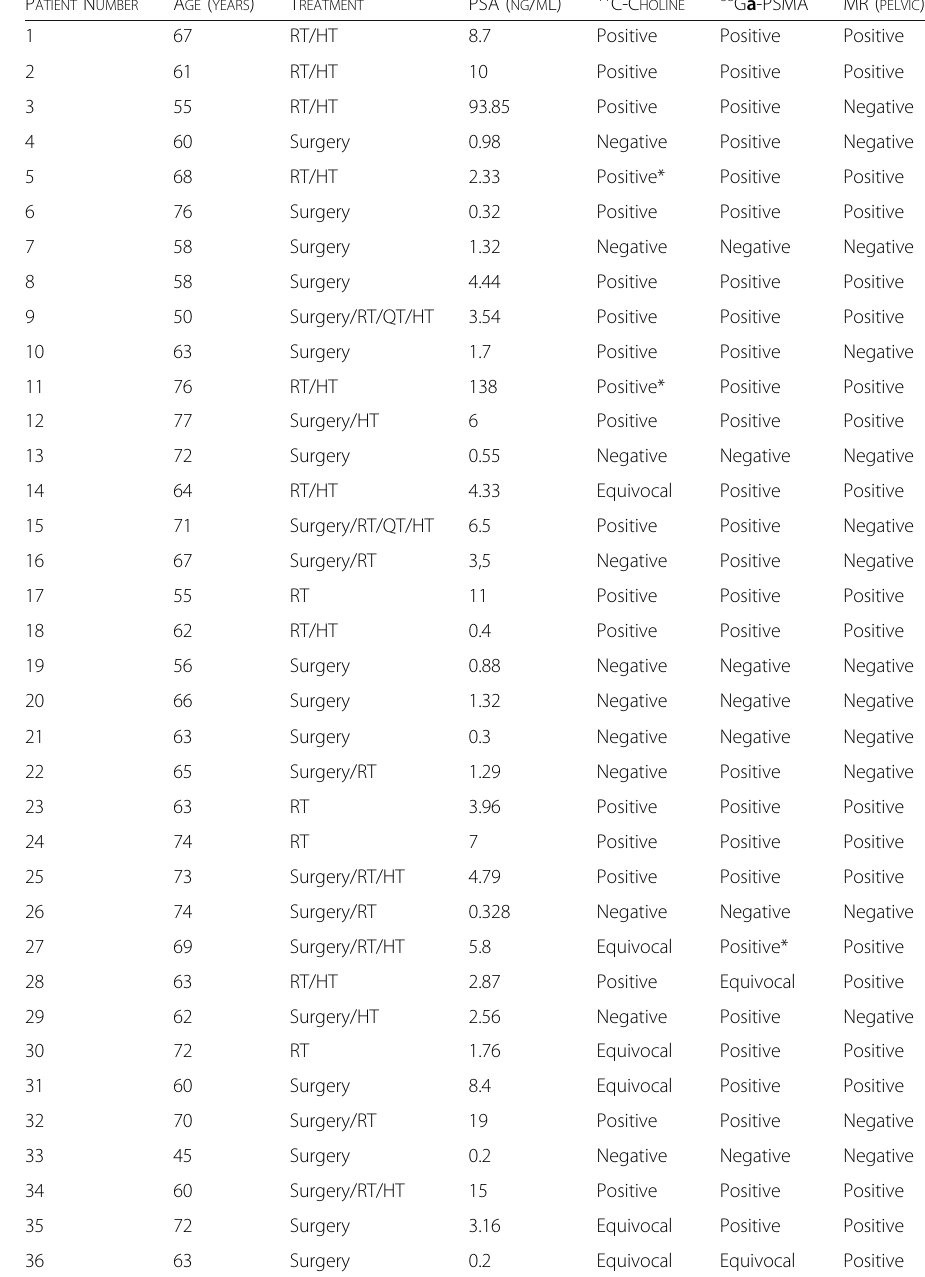
Table 1 Patient characteristics and scan